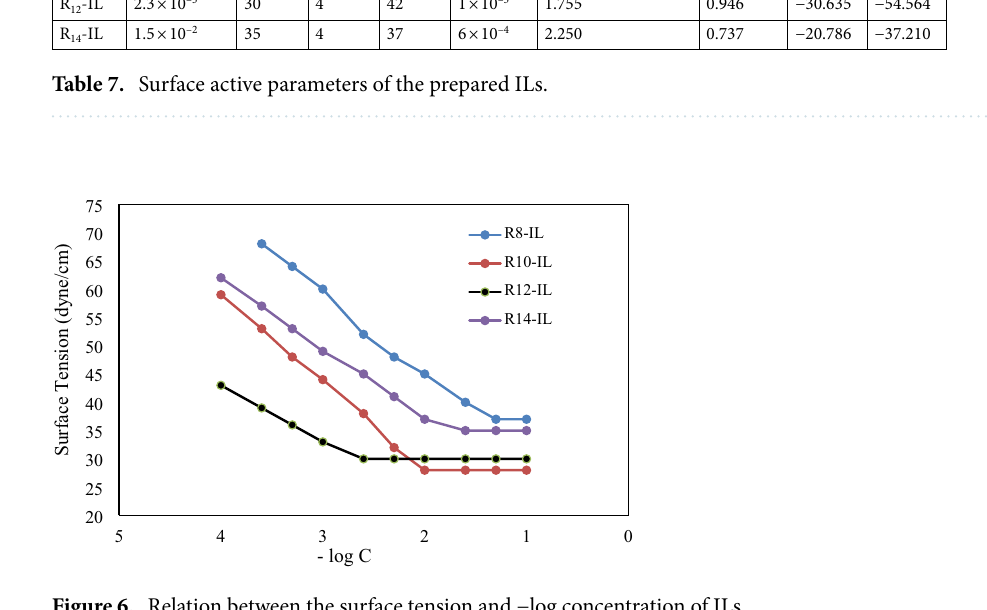
Figure 6. Relation between the surface tension and −log concentration of